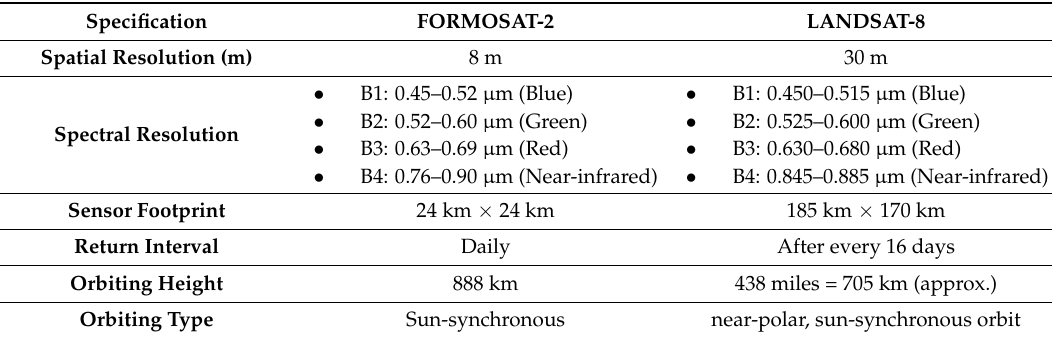
Table 1. Formosat and Landsat satellite specification.